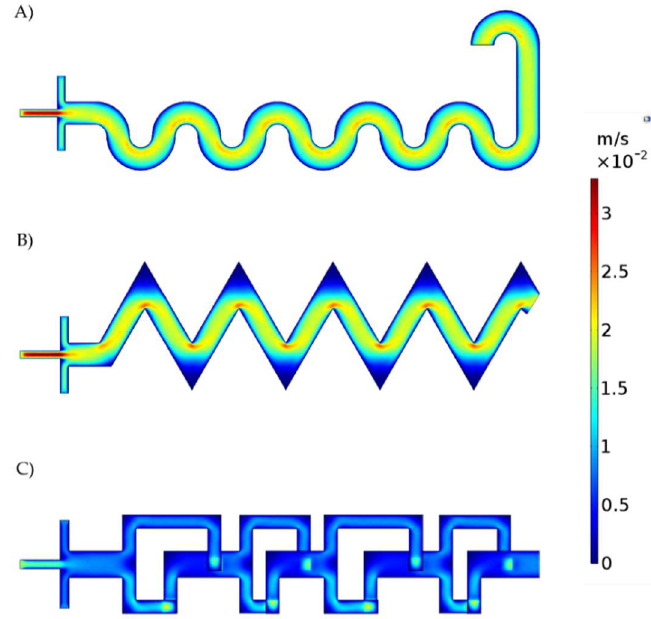
Figure 5. Velocity profile for each micromixer. ( A ) Serpentine−based (SB) micromixer, ( B ) Triangular−based micromixer (TB), and ( C ) 3D−based micromixer (3DB). Apparent flow discontinuities in 3DB are due to the projection of out−of−the plane channel segments.